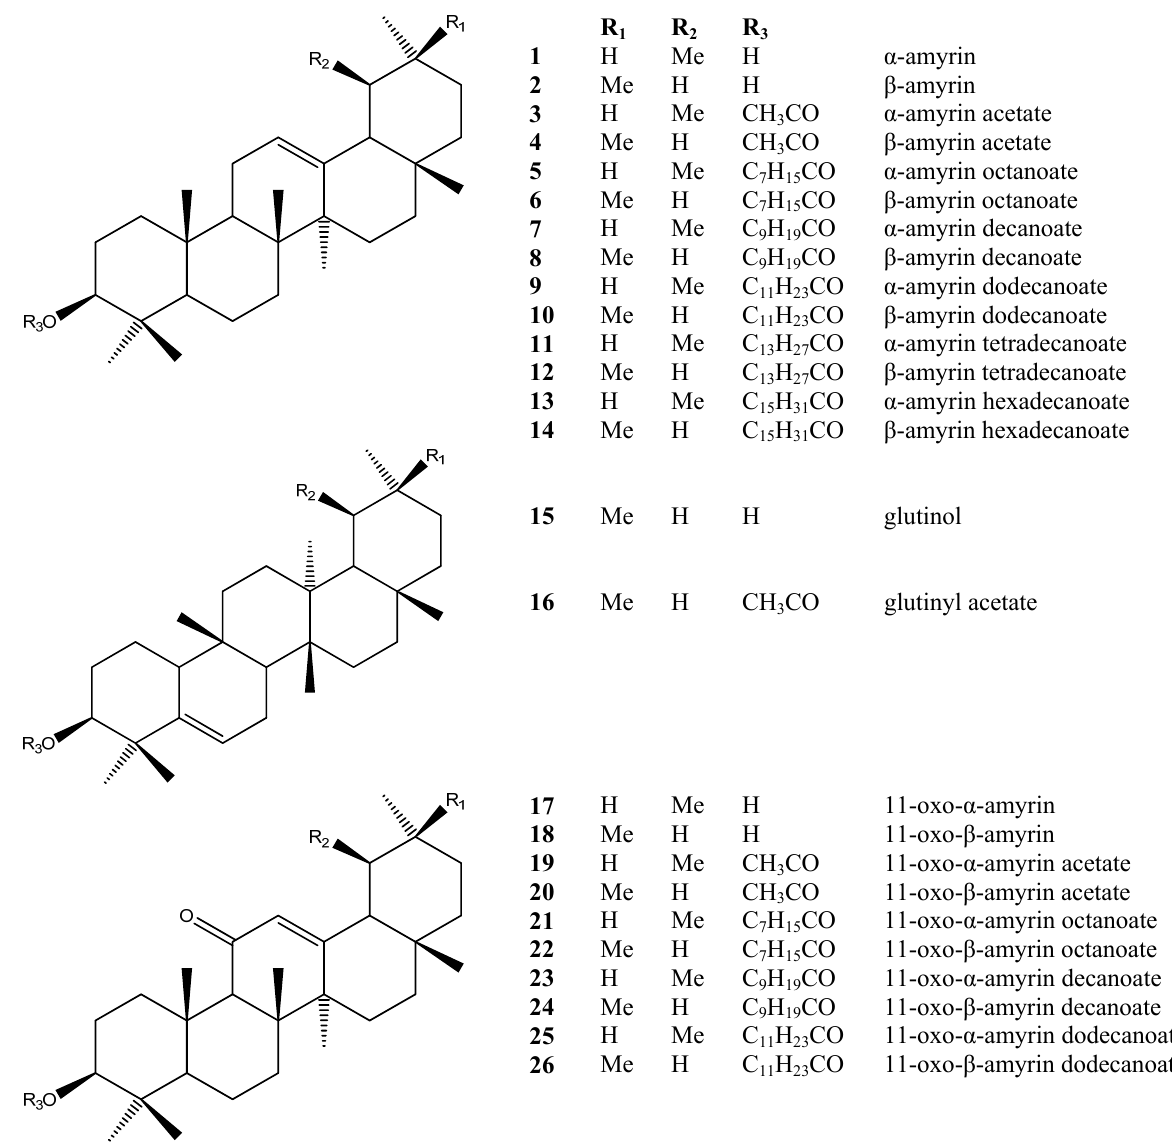
Figure 1. Chemical structures of the compounds detected by GC-MS in Dorstenia arifolia .